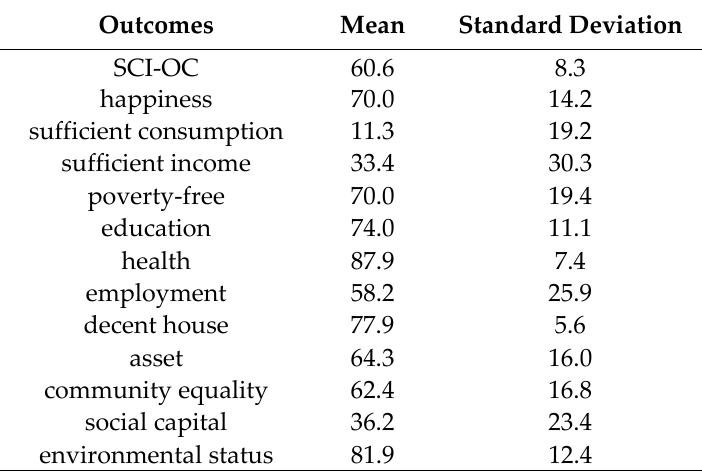
Table 2. SCI-OC and its element scores, Non-municipal Northeast 2017.